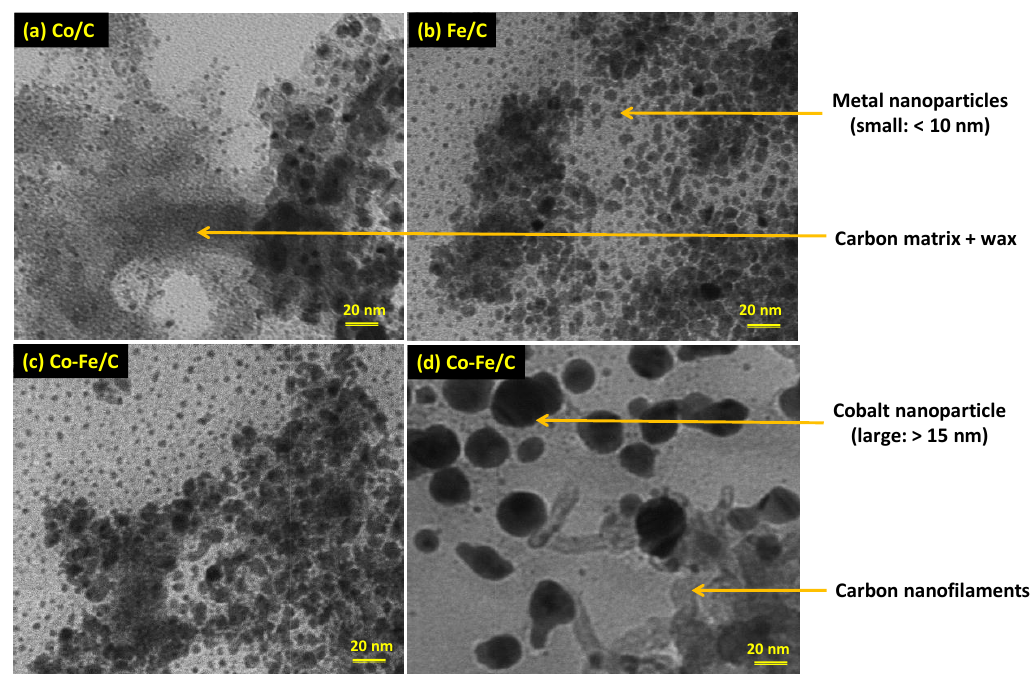
Figure 12. The TEM images of the used ( a ) Co/C ( b ) Fe/C and ( c ) Co-Fe/C catalysts with some sections having nanoparticles predominantly below ~5 nm, or ~10 nm, and ( d ) sections of the Co-Fe/C catalyst with larger nanoparticles ~20 nm and CNFs.